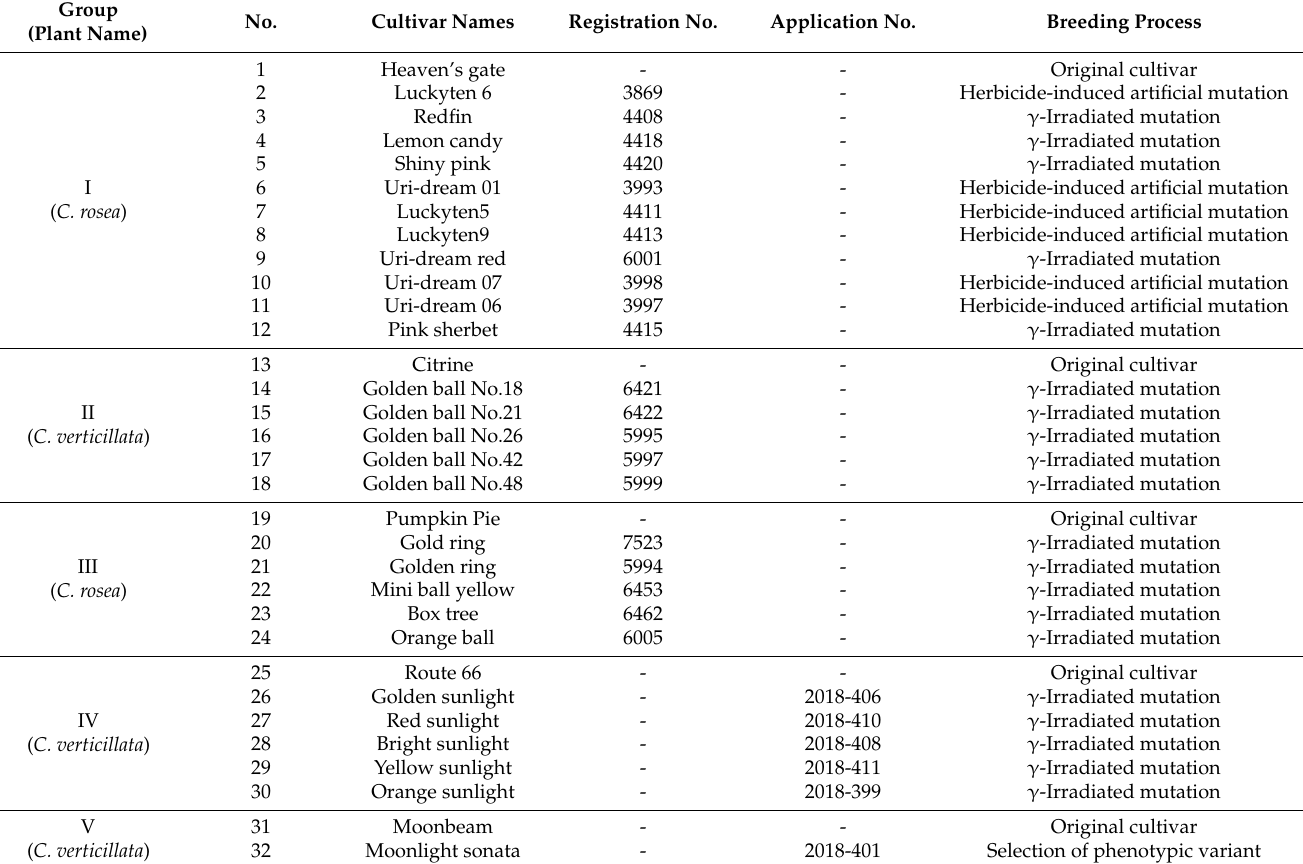
Table 1. The list of the original and mutant cultivars of Coreopsis rosea and Coreopsis verticillata used in this study. Group No. Cultivar Names Registration No. Application (Plant Name)